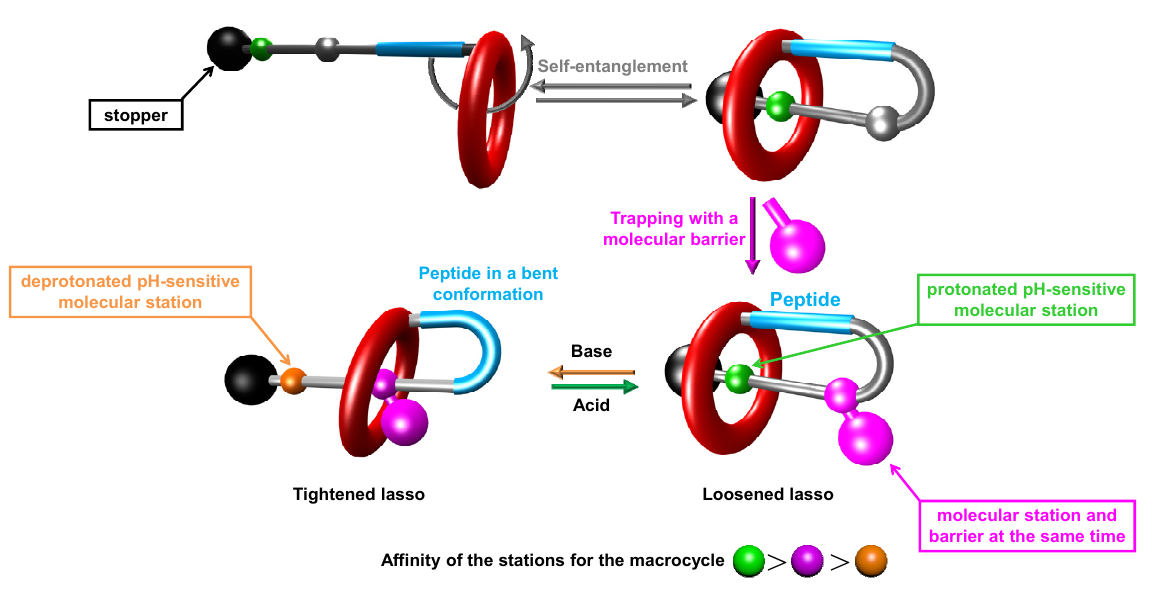
Figure 1. Cartoon representation of the molecular lasso targets and of the synthetic strategy used to prepare pH-sensitive peptide-containing lasso molecular